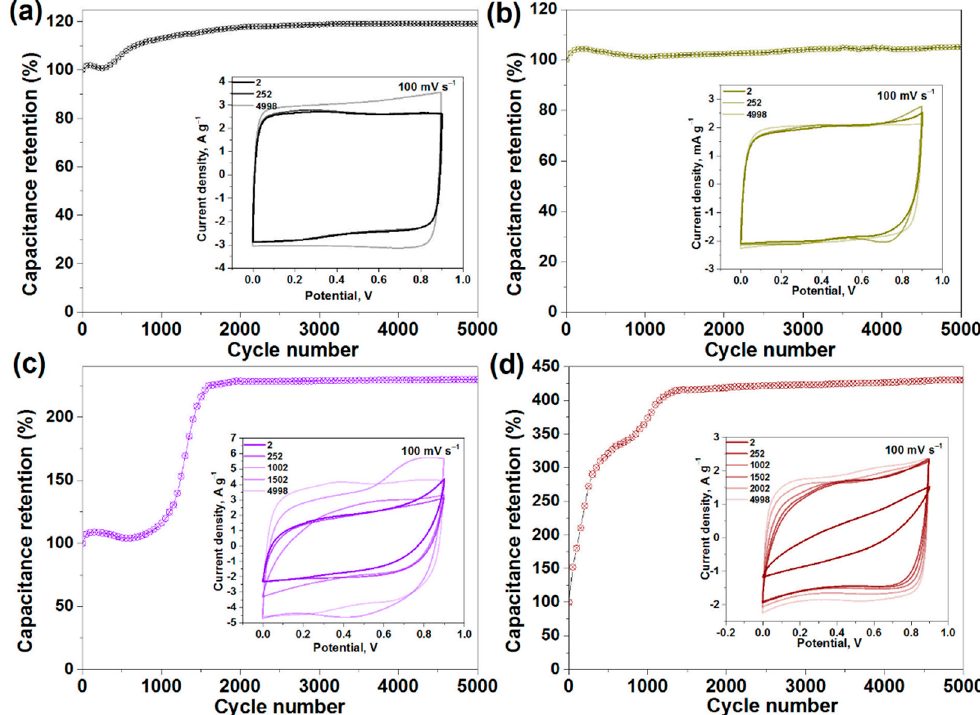
Figure 4. Capacitance retention for SW film ( a ), SW_DC film ( b ), F-SW film ( c ) and F-SW_DC film ( d ) during long-term cycling in 1M H 2 SO 4 electrolyte at a scan rate of 100 mV s − 1 in two-electrode cells. Insets show the CV curves measured at 2nd, 252nd, 1002th, 1502th, and 4998th cycles.